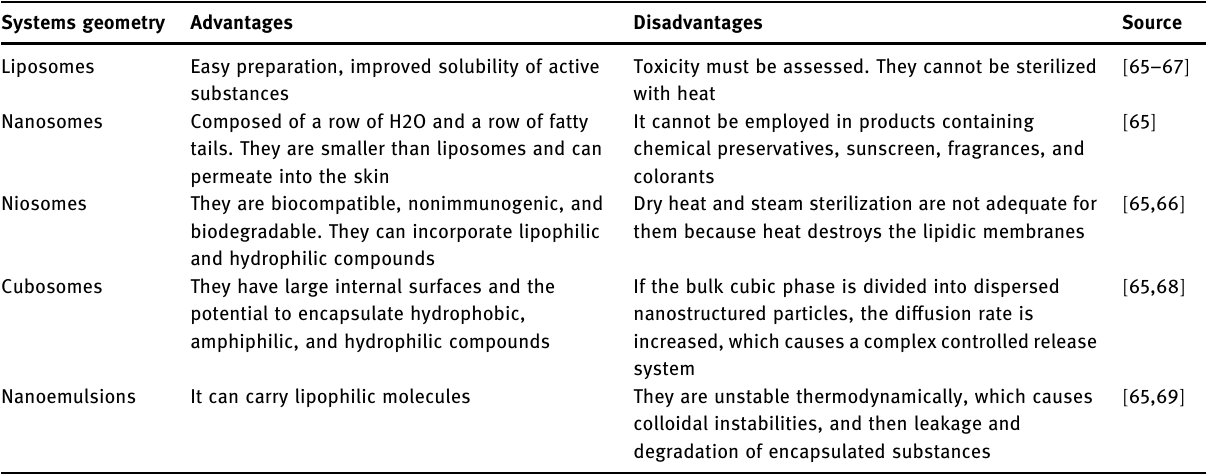
Table 1: Advantages and disadvantages of di ff erent forms of nanosystems or NPs Systems geometry